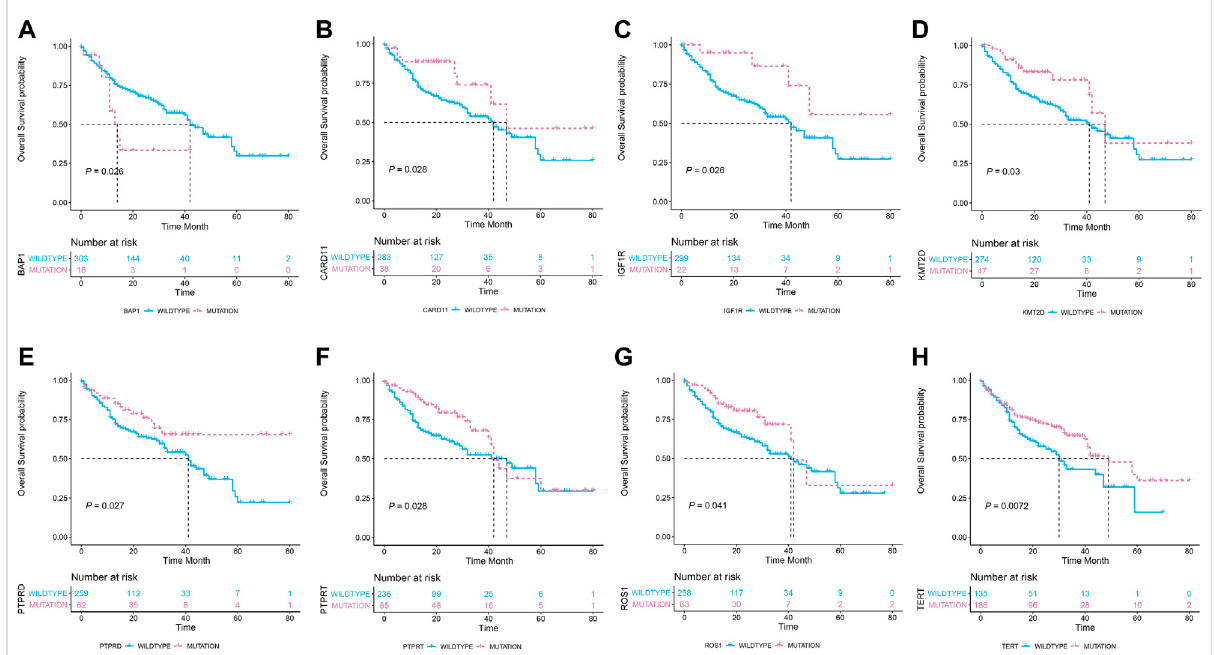
FIGURE 1 The association of the eight gene mutation statuses with the overall survival in 321 metastatic melanoma patients who received immune checkpointinhibitortreatments. (A) Patientscarrying BP1 mutations( n =18)hadpooroverallsurvivalthanthewildtypecounterparts( n =303). (B – H) : Patients carrying CARD11, IGF1R,KMT2D, PTPRD, PTPRT, ROS1, and TERT mutations had prolonged overall survivalthan their wildtype